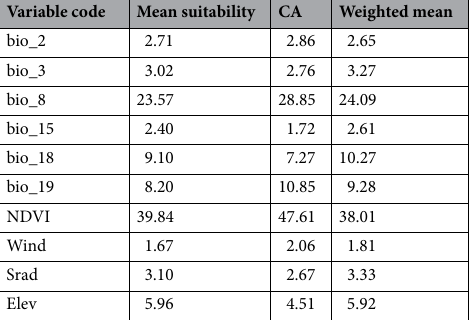
Table 3. 10 variables importance in the ensemble